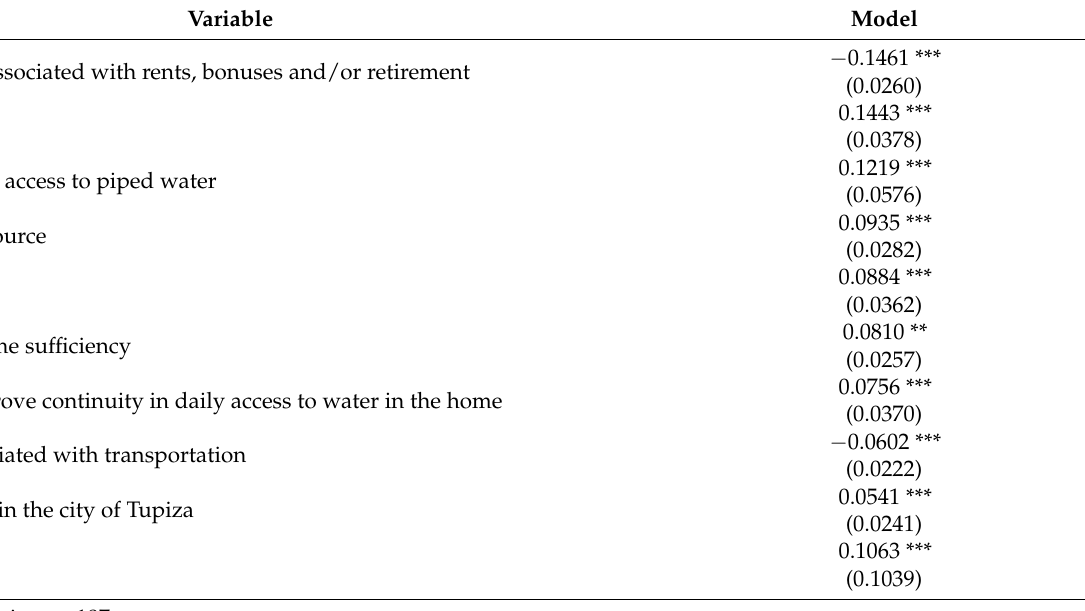
Table 9. Estimates of the poverty model for the urban area of the Tupiza River